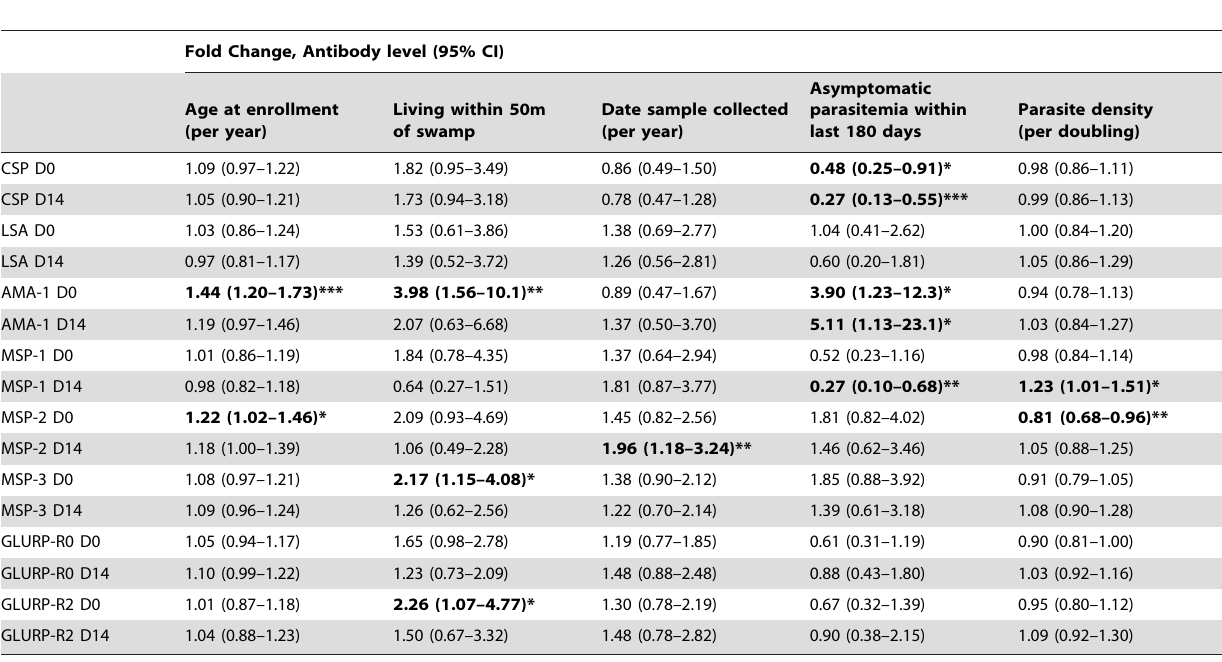
Table 2. Associations between epidemiologic measures of Plasmodium falciparum exposure and antibody levels.